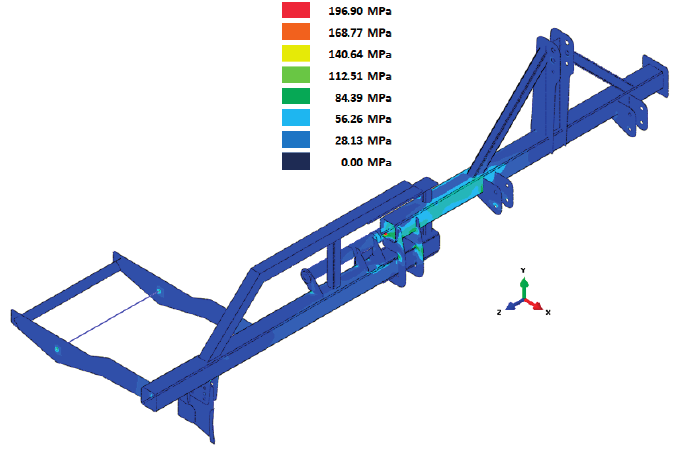
Figure 3. Results of Von Mises stress from the load case in which a force of 2610 N was applied to the furrow